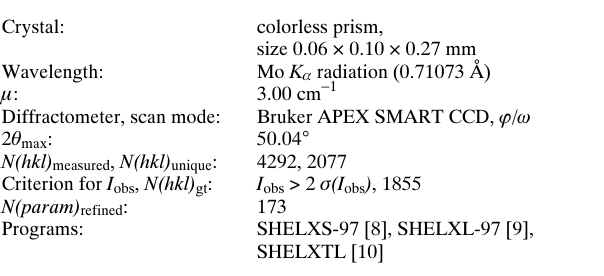
Table 1. Data collection and handling.